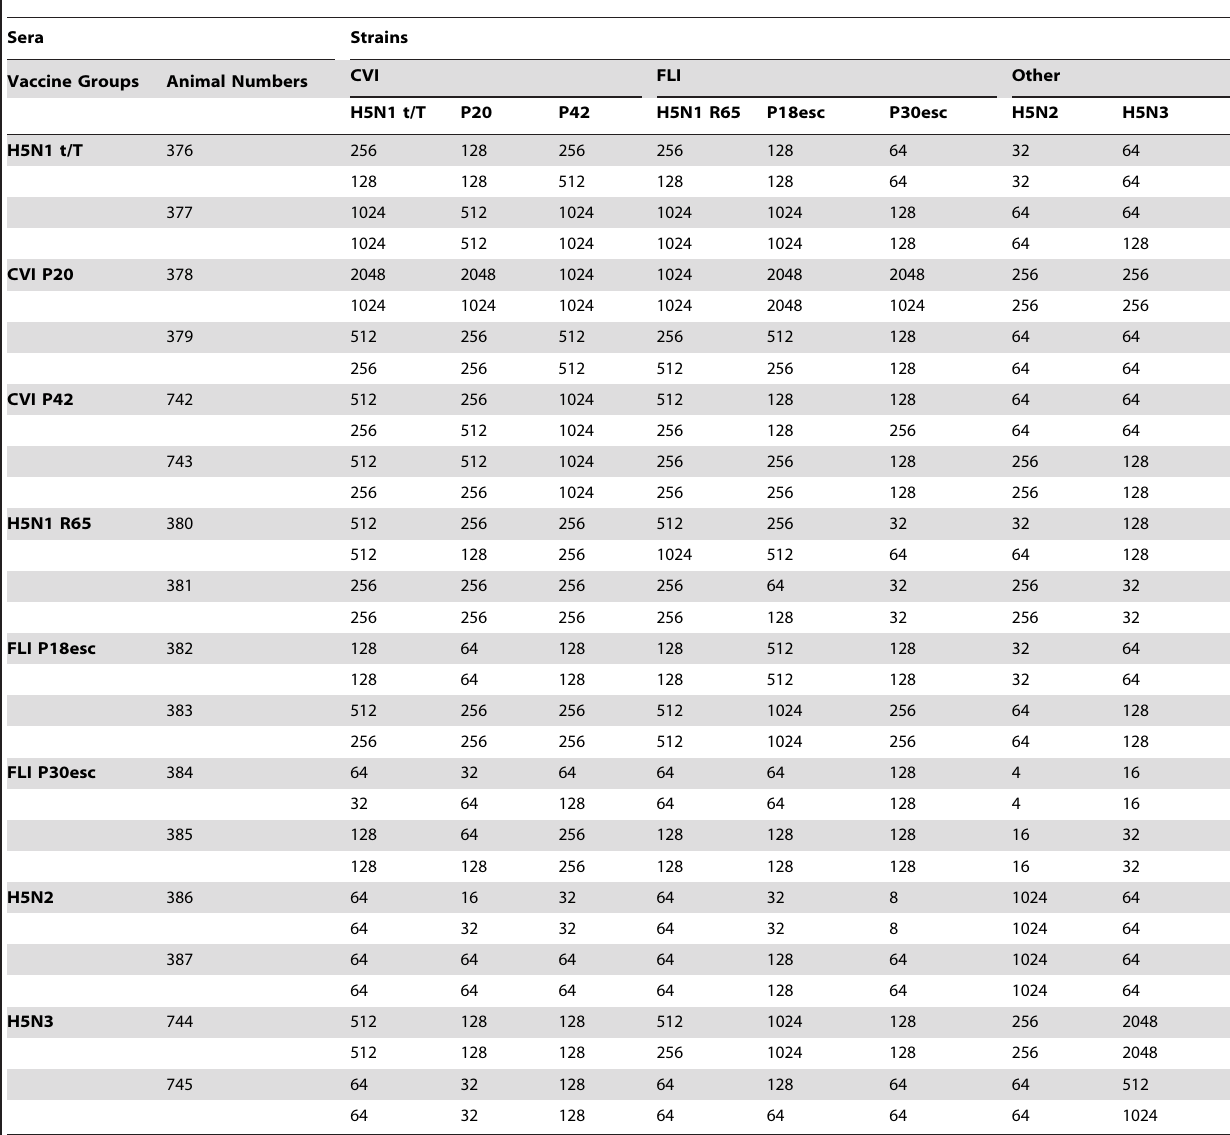
Table 3. HI data of strains and sera used for construction of antigenic maps.